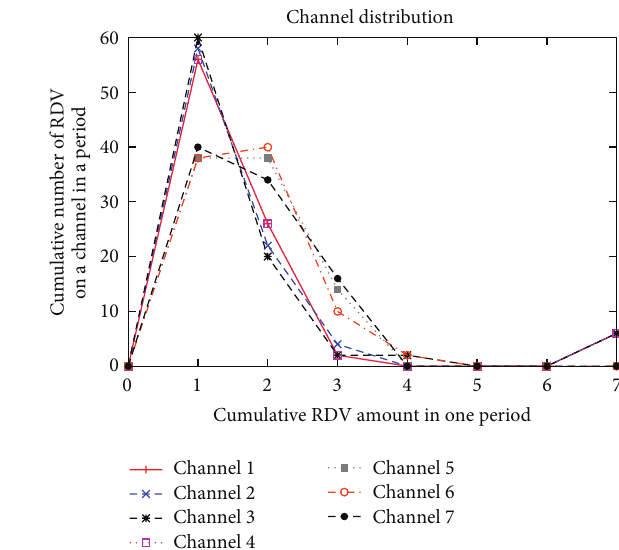
Figure 10: Common channel set: Map 6 Chs (66 slots).